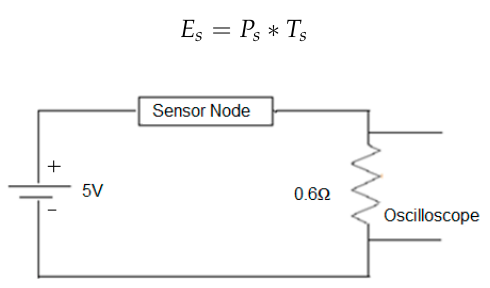
Figure 7. Experimental setup for investigating the energy consumption.